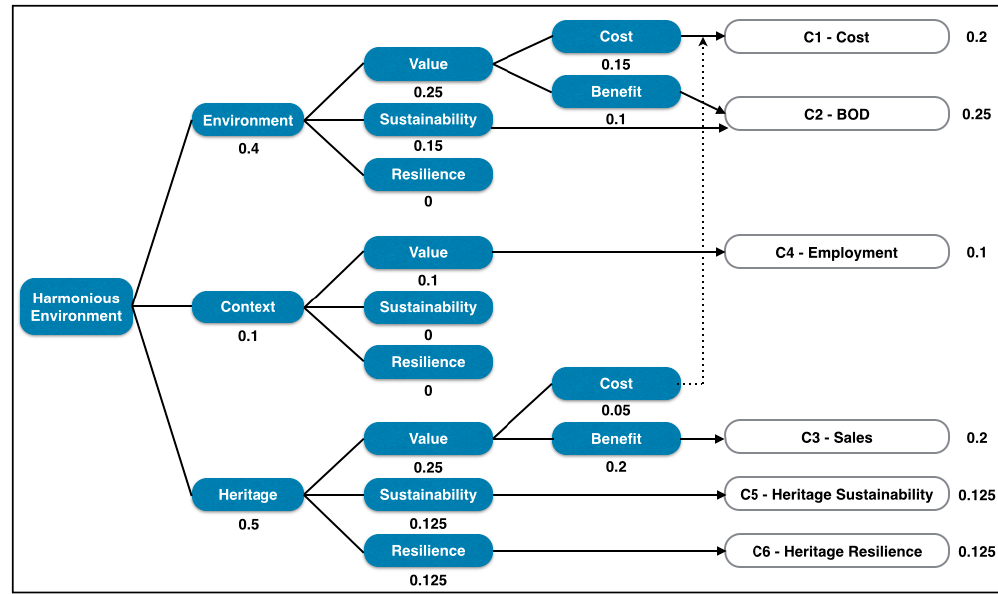
Figure 6. The criteria elicited and the pre-weighting. Legend: It must be noted that a criterion can consist of different sub-attributes (e.g., C1, C2), meaning the trade-off relation can exist at any level (e.g., C1: between heritage and environment; C2: between value, sustainability and